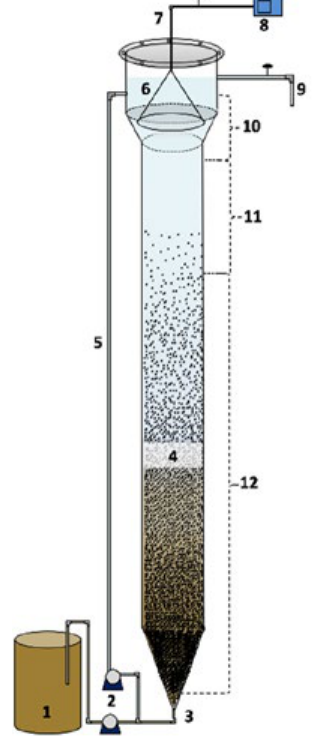
Fig. 1: The schematic diagram of an EGSB bioreactor. (1) Feed tank, (2) Peristaltic pump, (3) Influent, (4) EGSB bioreactor, (5) Recirculation, (6) Bell separation, (7) Biogas outlet, (8) Gas flow-meter, (9) Effluent, (10) Three-phase separator zone or Settling zone, (11) Transition zone, (12) Digestion zone.